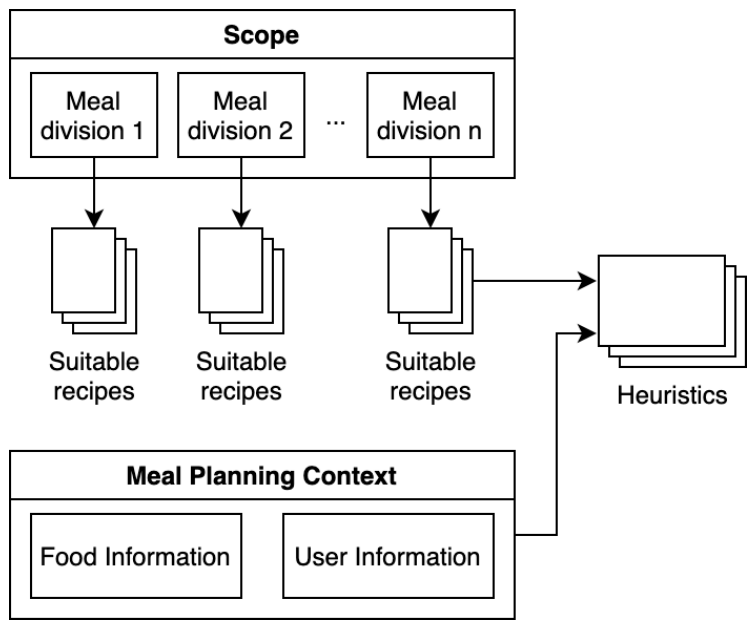
Figure 1. Overview of the concepts used in the problem